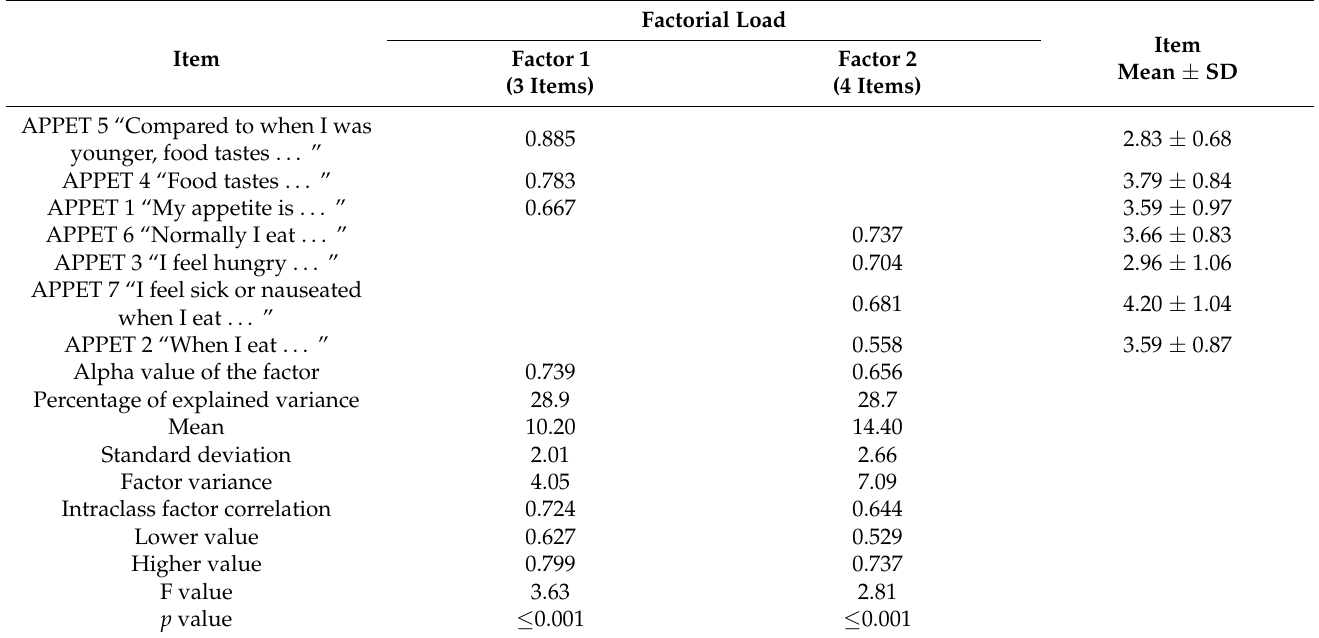
Table 1. Exploratory factor analysis of The Council on Nutrition Appetite Questionnaire (CNAQ) in a random sample of 121 Mexican patients with end-stage renal disease on hemodialysis. Total Cronbach’s alpha = 0.758; total mean = 24.6 ± 4; total variance = 16.1; Hotelling’s t -squared test, F = 376.6, 116 df , p ≤ 0.000; Total explained variance =